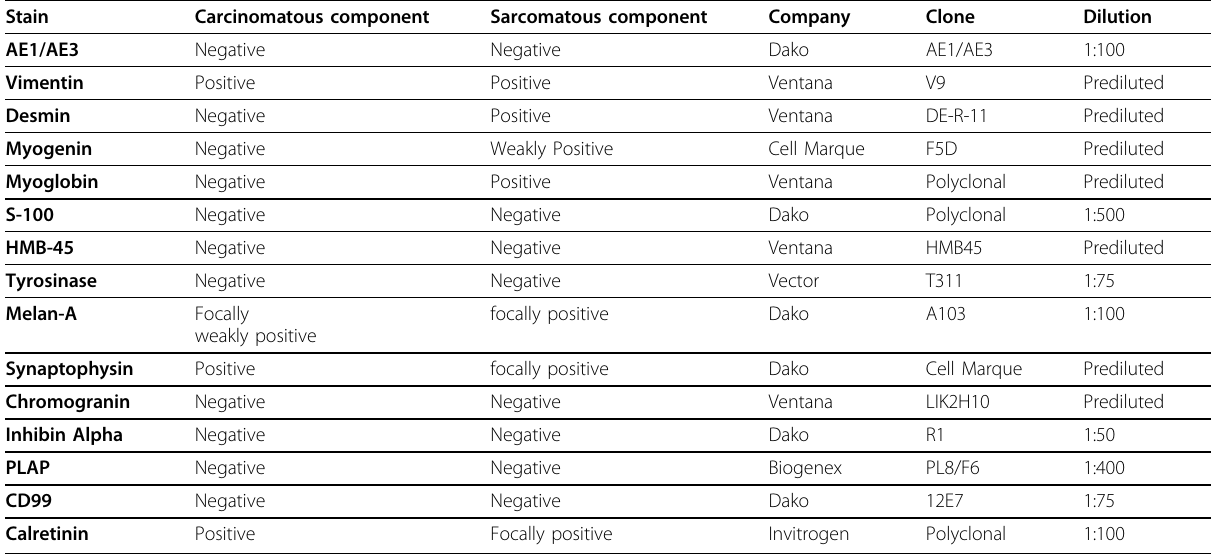
Table 1 Adrenocortical carcinosarcoma immunohistochemical profile